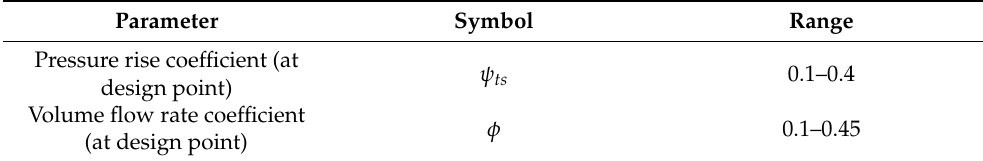
Figure 4. Design space (i.e., pairs of φ and ψ ts ) for the class of single-stage axial impeller-only fans; the colour indicates the peak efficiency achievable for each pair of φ and ψ ts ; after Bamberger [8]. Table 2. Aerodynamic design parameters varied in the present